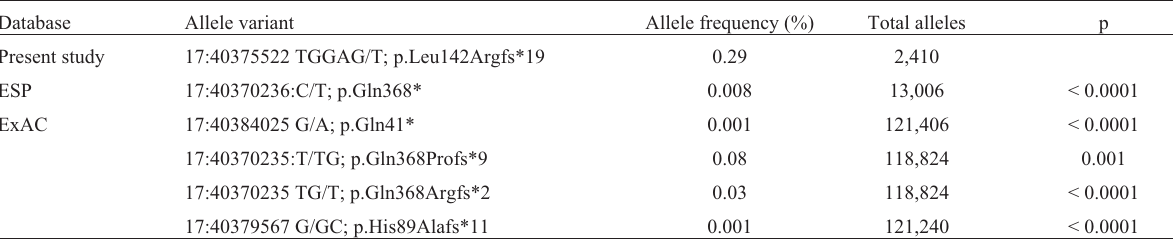
Table 1 - Allele frequencies of pathogenic STAT5B variants in the present study and in public databases. Database